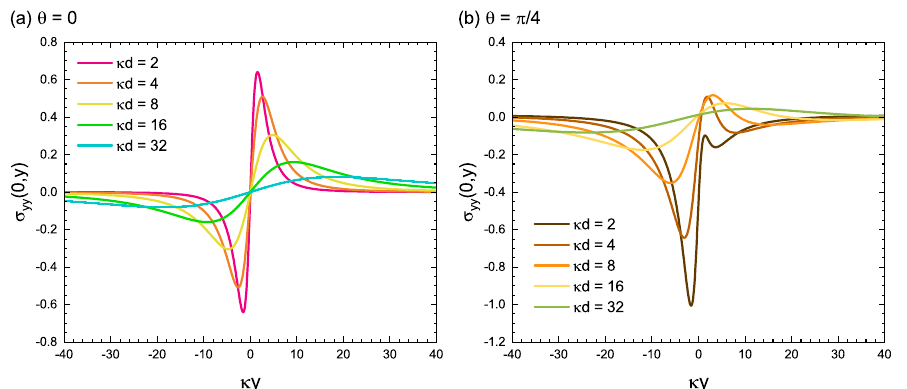
Figure 6. Spatial distribution of the stress component σ yy ( 0, y ) along the free surface of x = 0. The closer the dislocation is to the surface, the sharper are the peaks near y = 0. The relative angle of the Burgers vector to the normal of the free surface is set to ( a ) θ = 0 and ( b ) θ = π